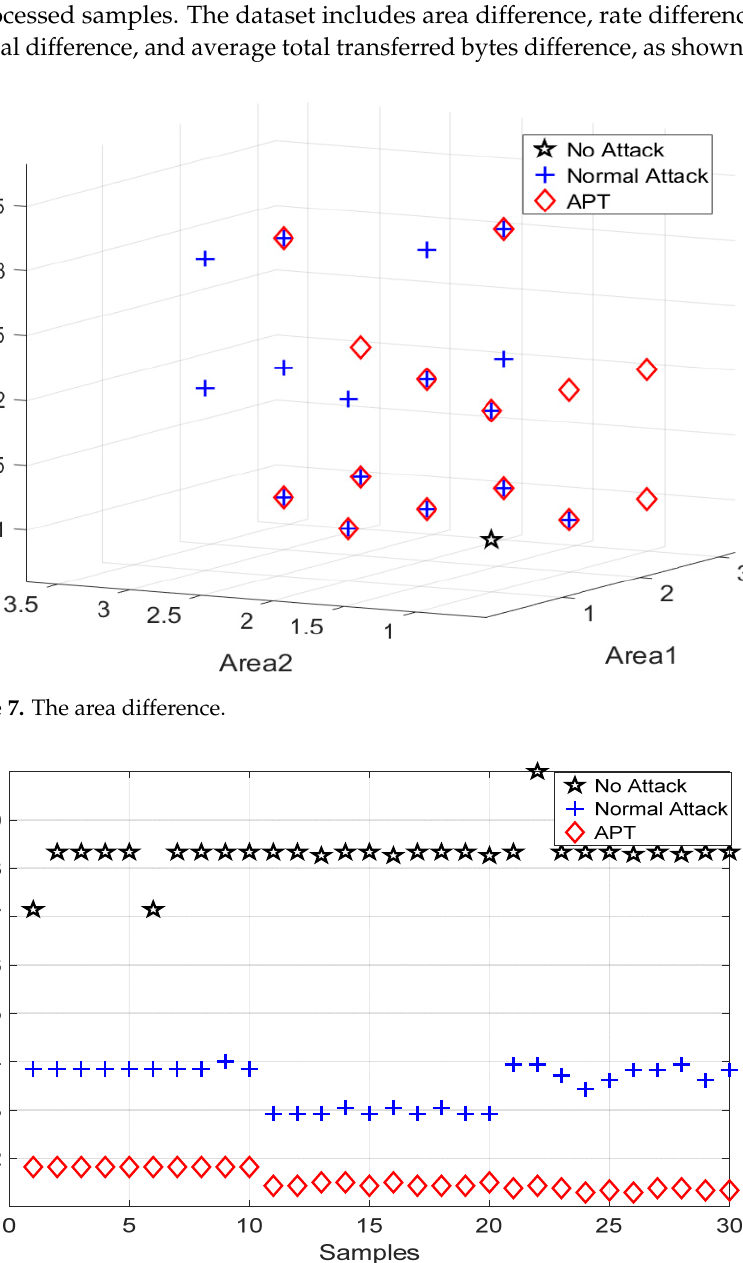
Figure 8. The rate difference.